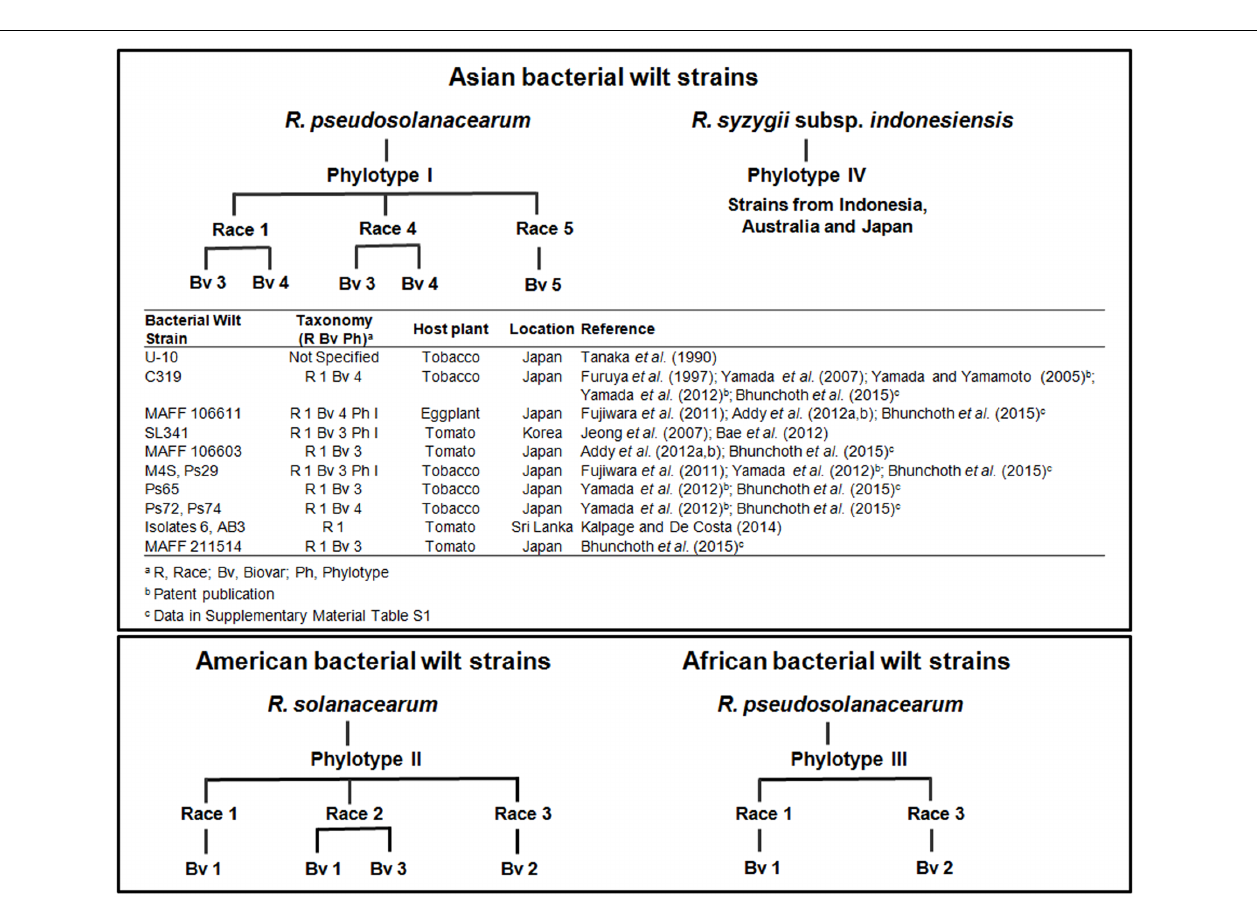
Frontiers in Plant Science |